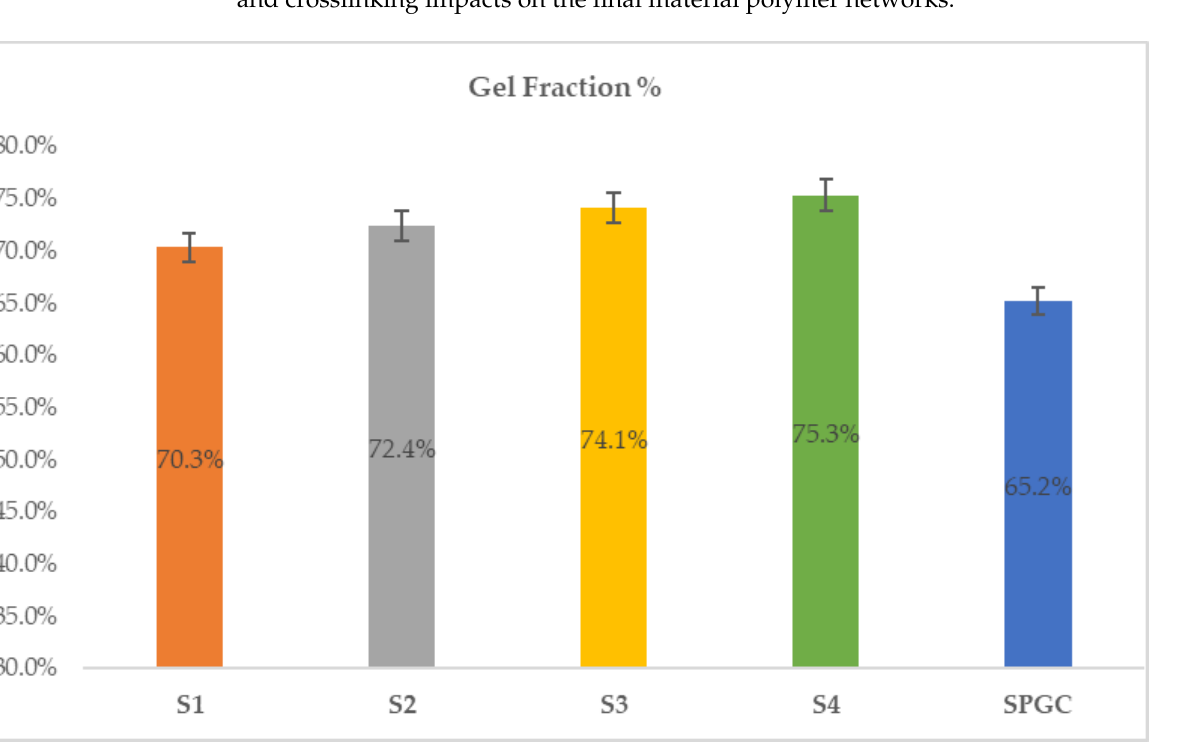
Figure 8. Weight-loss percentage comparison of the starch-based film (SPGC) and the samples (S1– S4) with nZnO . The starch/polyvinyl alcohol/nZnO wound dressings’ (S1–S4) degradation proper- ties may be altered by the citric acid concentrations and crosslinking temperature, and the results approve the solubility data as they refer to biodegradability enhancement of such blends or materials. The wound exudate partially dissolves these films and informs a hy- drophilic wound dressing that keeps the wound safe from infections and encourages